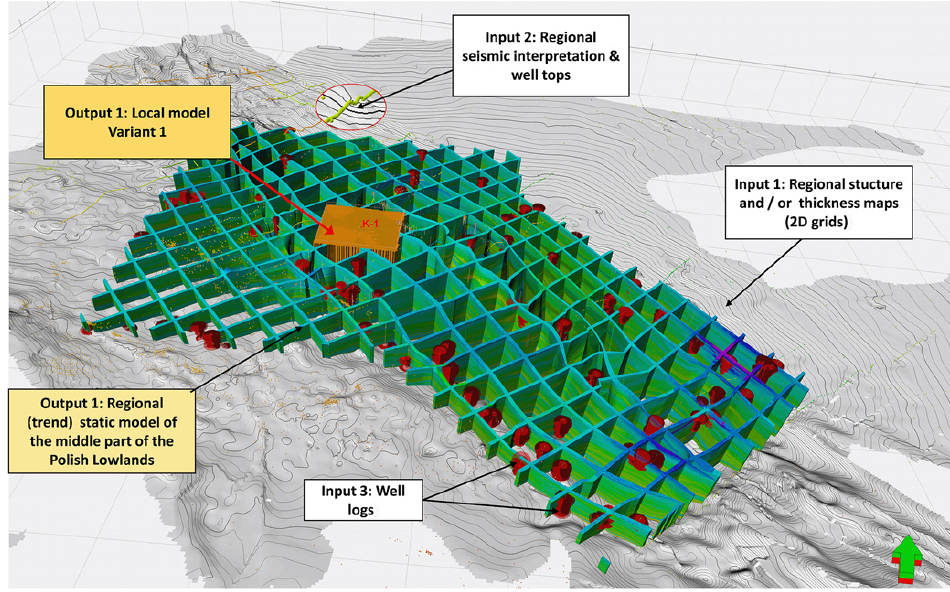
Figure 6. An example of input data applied for generation the first variant of the structural model (SMV1).